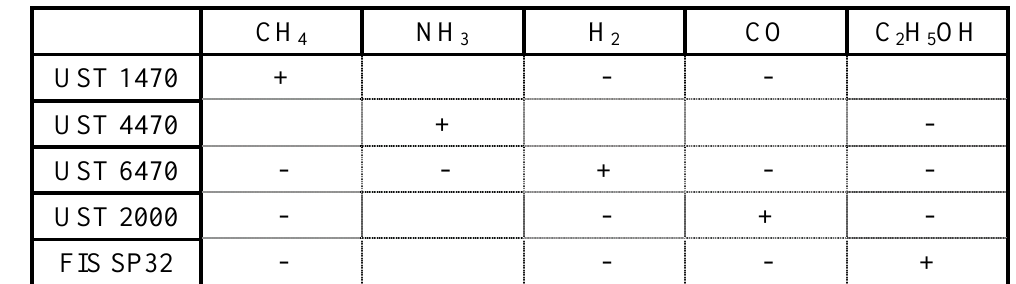
Table 1. Gas sensors of the simulated array and their cross- and main sensitivity; (+) symbol denotes main sensitivity and (-) denotes